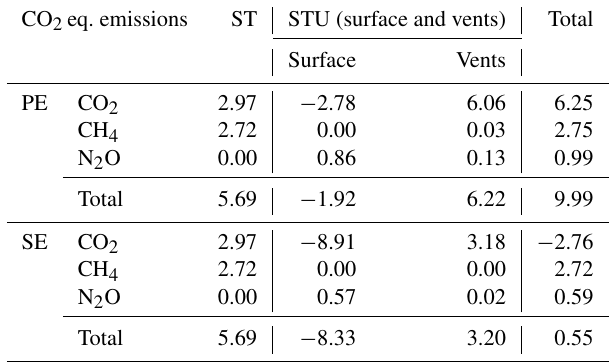
Table 2. Total net greenhouse gas emissions from the two differ- ent treatment configurations: septic tank-STU (PE) and septic tank- packaged secondary treatment system-STU (SE). All emissions are given in kg-CO 2 eq . cap − 1 yr − 1